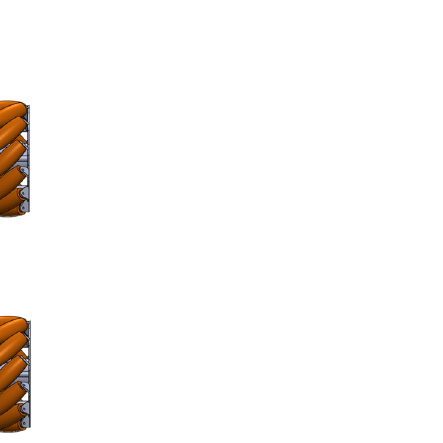
Figure 3. The control architecture of Omnibot.